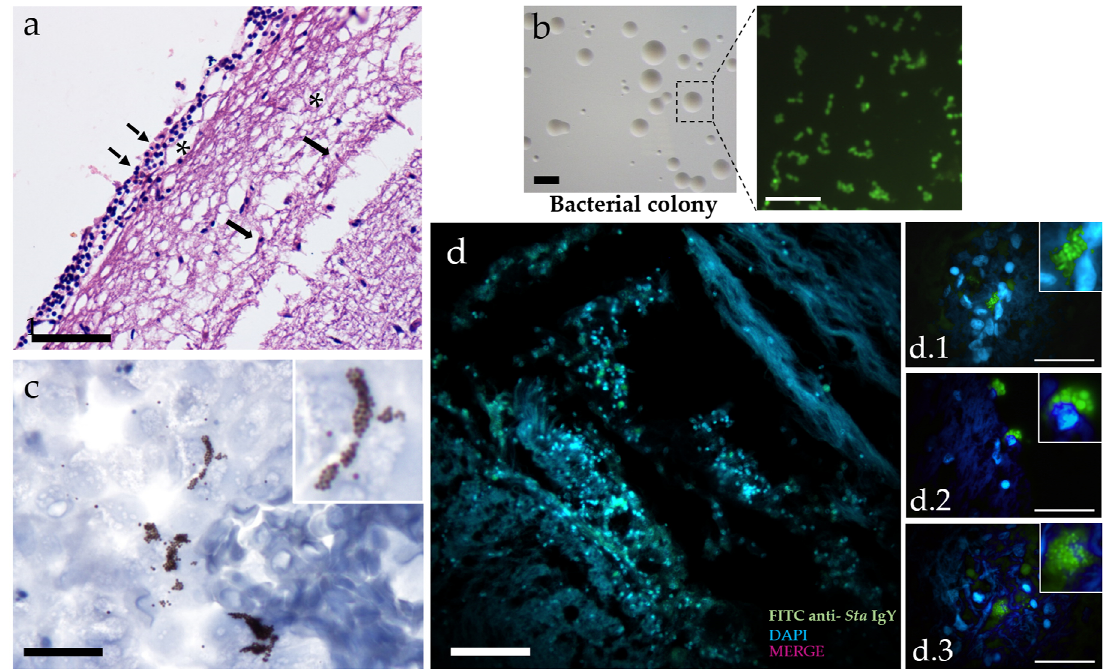
Figure 1. Mechanism of S. agalactiae ( Sta ) infection in the brain of Nile tilapia ( Oreochromis niloticus ). ( a ) Histopathological lesions in cerebral tissue of Nile tilapia infected with Sta . The dotted arrows indicate leukocyte infiltrates, asterisks indicate suppurative lesions, and arrows indicate microglial migration. ( b ) Microbiological identification by immunofluorescence of Sta isolated from the brain of tilapias 7 days after infection. ( c ) Detection of Sta in brain tissue by IHC ( c ) immunofluorescence (IMF) ( d ) Sta in the light of meningeal endothelium ( d.1 ) intracellular phase without phagocyte ( d.2 ) and, free form colonies of Sta in the interstice of brain tissue ( d.3 ). Bar = 25–50–100 µ m: hematoxylin and eosin staining (H&E); IMF stain: DAPI = nucleus (blue) and fluorescein isothiocyanate (FITC) = IgY anti- S. agalactiae (green).